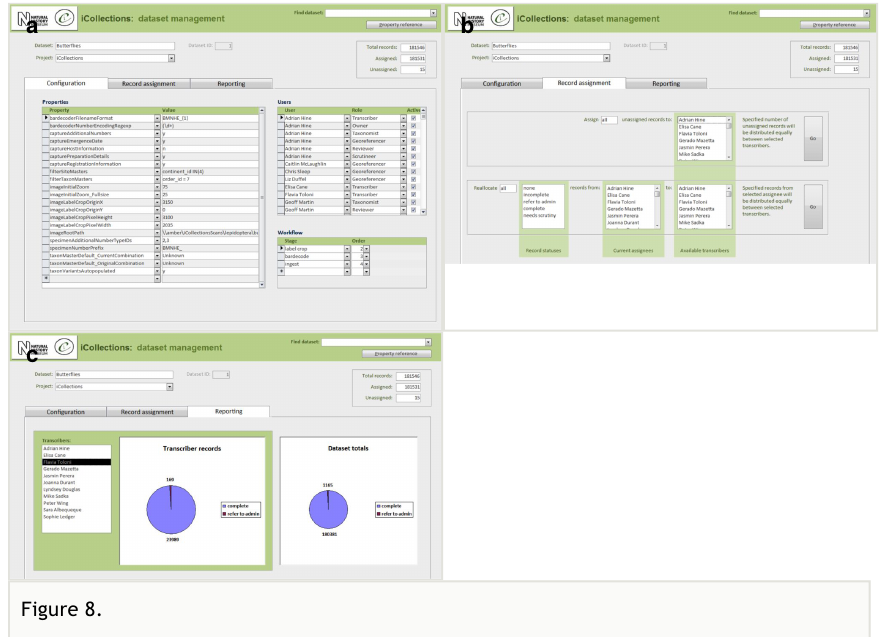
Project and user administration screens (from the fi nal version of the